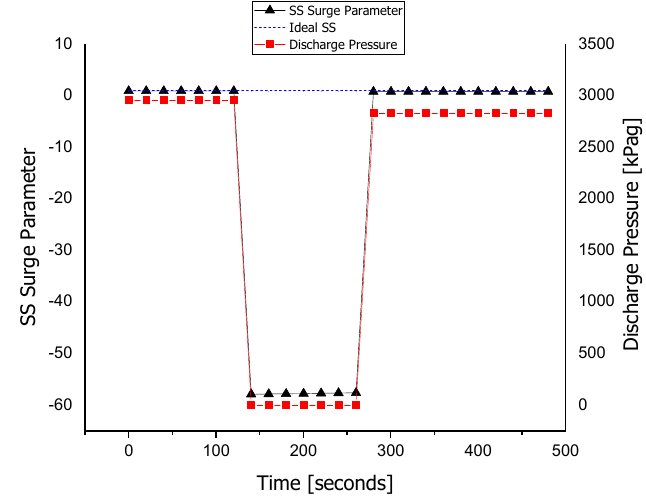
Figure 13. The fault tolerance in the discharge pressure sensor.